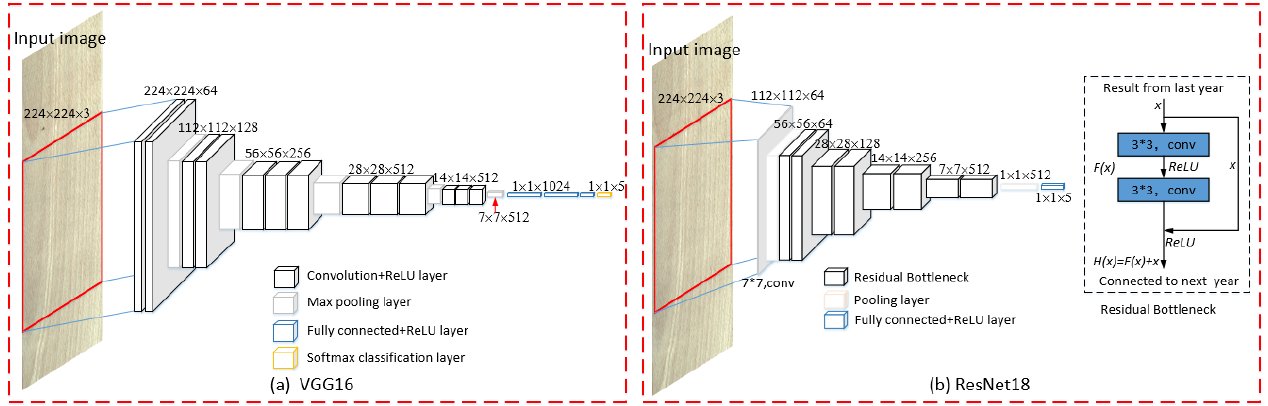
Figure 3. VGG and ResNet network structure diagram.